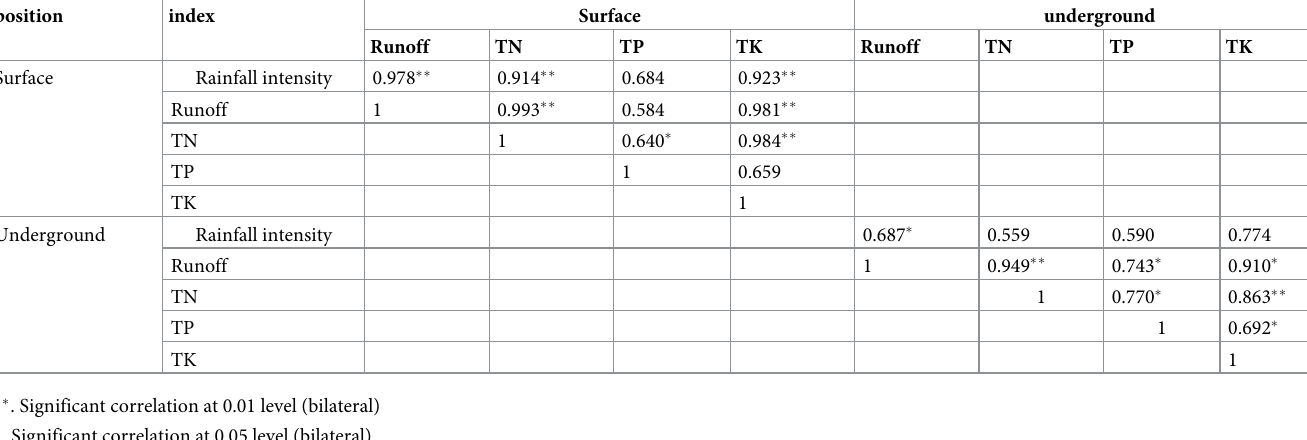
Table 5. Correlation analysis of nutrient loss, rainfall intensity, and runoff.